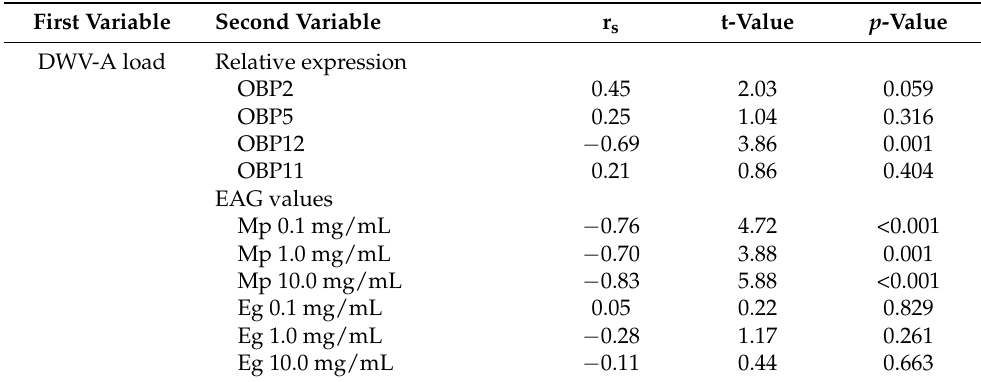
Table 2. Spearman correlation analysis between the viral load, OBPs gene relative expression, and EAG values in DWV-A inoculated worker honey